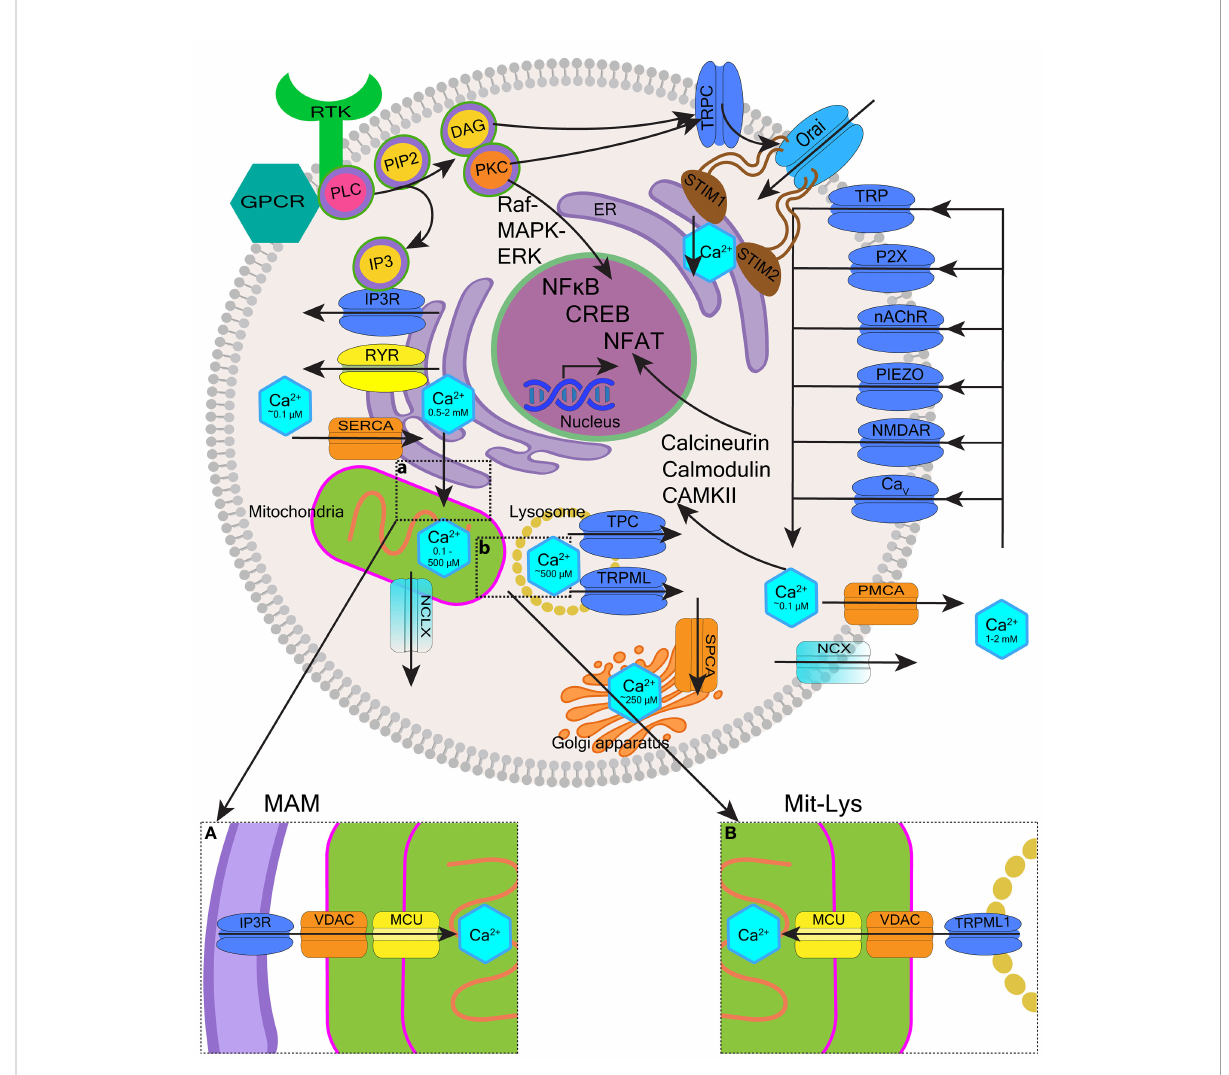
FIGURE 1 Overview of intracellular calcium homeostasis. Calcium homeostasis is maintained by the in fl ux and ef fl ux of Ca 2+ through calcium channels and pumps located on the plasma membrane, as well as membranes of organelles such as the endoplasmic reticulum (ER), the Golgi apparatus, mitochondria, and endo-lysosomes. The cytoplasm, extracellular space, and each organelle have unique resting Ca 2+ concentrations that have been indicated. Extracellular Ca 2+ is transported into the cytosol through different channels such as transient receptor potential (TRP) channels, purinergic receptor (P2X) channels, nicotinic acetylcholine receptor (nAChR) channels, Piezo mechanosensitive channels, ionotropic glutamate receptor channels (e.g. N-methyl-D-aspartate receptors, NMDARs), and voltage-gated calcium (Ca v ) channels. Ca 2+ is removed from the cytosol to the extracellular space by plasma membrane calcium ATPase (PMCA) ef fl ux pumps and sodium-calcium exchangers (NCX). Activation of cell surface transmembrane receptors with tyrosine-based activation motifs (RTK e.g. B-cell and T-cell receptors) or G-protein coupled receptors (GPCR e.g. neurokinin-1 receptor) activate phospholipase C (PLC). PLC hydrolyses phosphatidylinositol-4,5-bisphosphate (PIP2) located in the plasma membrane which generates two second messengers inositol 1,4,5- trisphosphate (IP3) and 1,2-diacylglycerol (DAG). IP3 binds to IP3 receptors (IP3Rs) located on the ER membrane leading to the release of Ca 2+ from the ER and DAG activates protein kinase C (PKC). Depletion of ER Ca 2+ activates stromal interaction molecules STIM1-STIM2 (located in the ER membrane), which then activates Orai1-Orai3 channels (located in the plasma membrane) to induce Ca 2+ in fl ux into the cytosol. This mechanism is called store-operated calcium entry (SOCE). Ryanodine receptors (RYRs) represent an alternative pathway for Ca 2+ release from the ER regulated by Ca 2+ , Mg 2+ and other molecules including ATP, calmodulin and CaMKII. The Ca 2+ concentration in the ER is replenished via sarco-endoplasmic reticulum calcium ATPase 2b (SERCA2b) pump. The in fl ux of Ca 2+ from the ER to mitochondria occurs through voltage-dependent anion channels (VDAC) and mitochondrial calcium uniport (MCU) located in high numbers within mitochondria-associated ER membranes (MAMs) ( insert a ). Ca 2+ leaves mitochondria mostly through Na + /Ca 2 + /Li + exchanger (NCLX). Ca 2+ stored in the endo-lysosomes is mobilized mostly by two-pore channels (TPC) and transient receptor potential mucolipin (TRPML) channels in response to nicotinic acid adenine dinucleotide phosphate (NAADP.) TRPML1 is involved in the mitochondrial-lysosomal contact sites (Mit-Lys), facilitating Ca 2+ transfer to mitochondria through VDAC and MCU ( insert b ). Multiple effector molecules mediate effects of Ca 2+ signaling including PKC, Raf-MAPK (mitogen-activated protein kinase)-ERK (extracellular signal-regulated kinase), calmodulin, calcium/calmodulin-dependent protein kinases (e.g. CaMKII), and calcineurin. These signaling molecules in fl uence gene expression through transcription factors such as nuclear factor kappa B (NF- k B), cyclic adenosine monophosphate (cAMP) response element-binding protein (CREB), and nuclear factor of activated T-cells